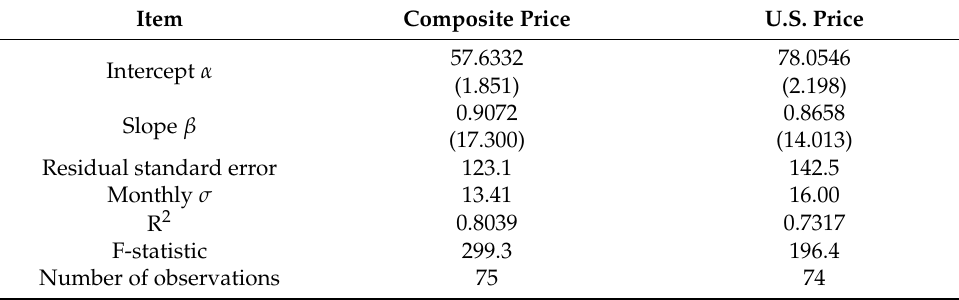
Table 2. Parameter Estimates for Stochastic Process Model a